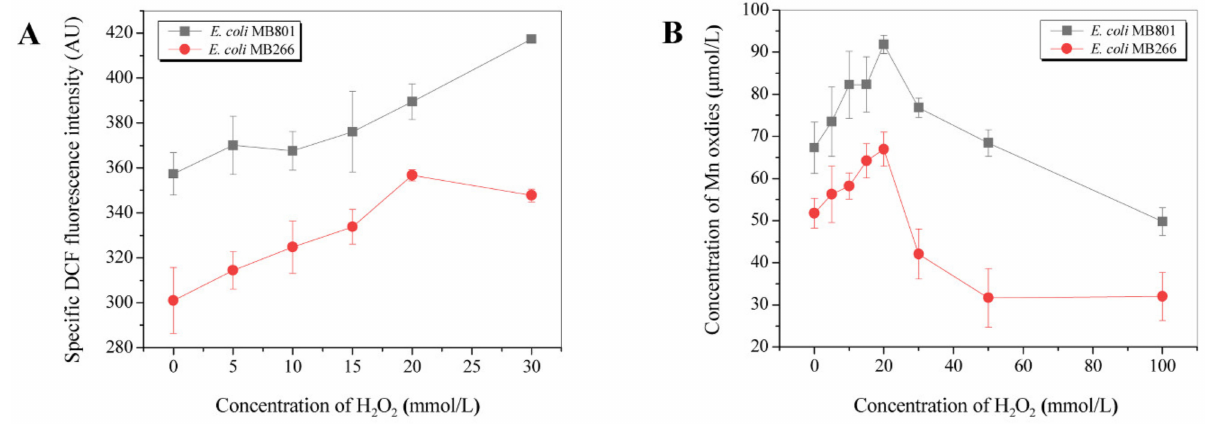
Figure 6. Effect of ROS on the MnODA of MB801. In ( A ), the cells were cultured for 24 h prior to the addition of H 2 O 2 at various concentrations. The specific DCF fluorescence intensity was recorded. In ( B ), the MnODA of the cells was determined after culturing the cells for 5 days with H 2 O 2 at different concentrations.